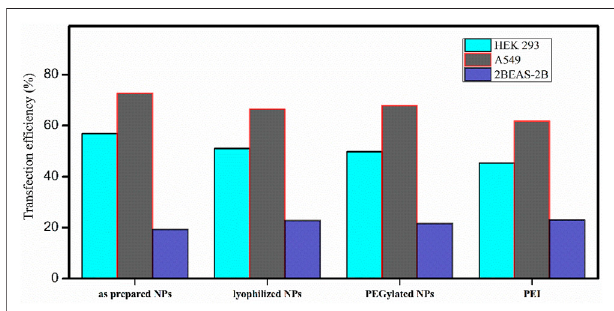
FIGURE 9 | Transfection ef fi ciencies of P β AE-447 and PEI toward A- 549, HEK 293, and BEAS-2B were calculated by ImageJ (n = 3).